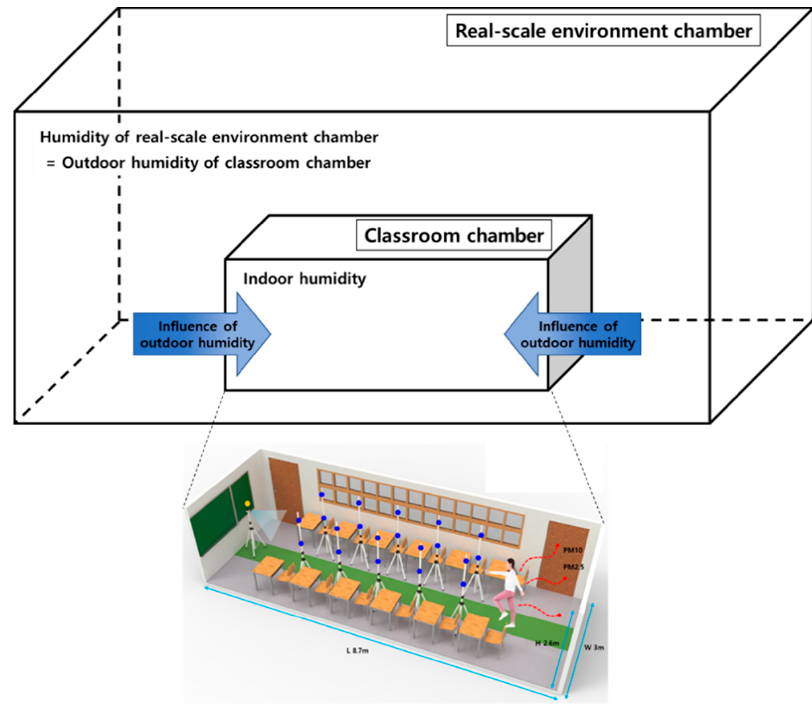
Figure 3. Schematic diagram of PM resuspension experiment in classroom chamber under various humidity conditions.